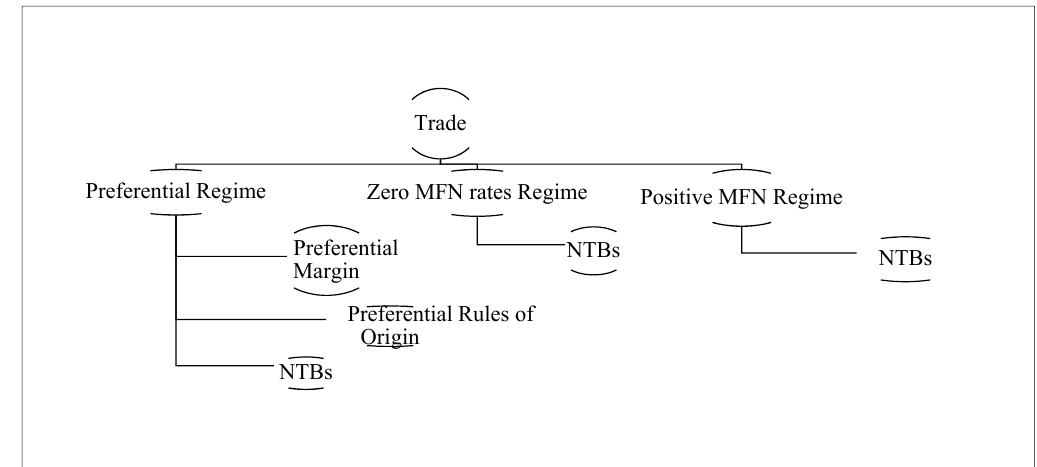
Figure 1. Hierarchical structure of trade policies. Source: authors’ elaborations.